Question: Draft a figure caption describing what is shown.
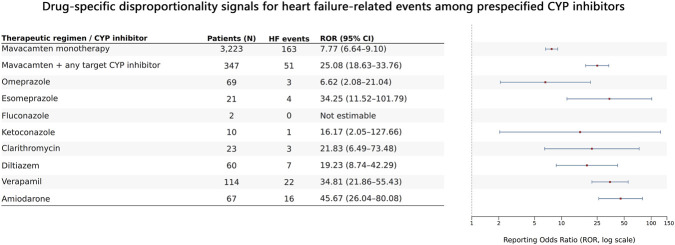
Answer: Drug-specific disproportionality signals for heart failure-related reports among prespecified CYP inhibitors. Forest plot showing reporting odds ratios (RORs) and 95% confidence intervals (CIs). Drug-specific counts correspond to Supplementary Table S2 . Rows are not mutually exclusive because individual reports may contain more than one CYP inhibitor. Abbreviations: CYP, cytochrome P450; ROR, reporting odds ratio; CI, confidence interval.